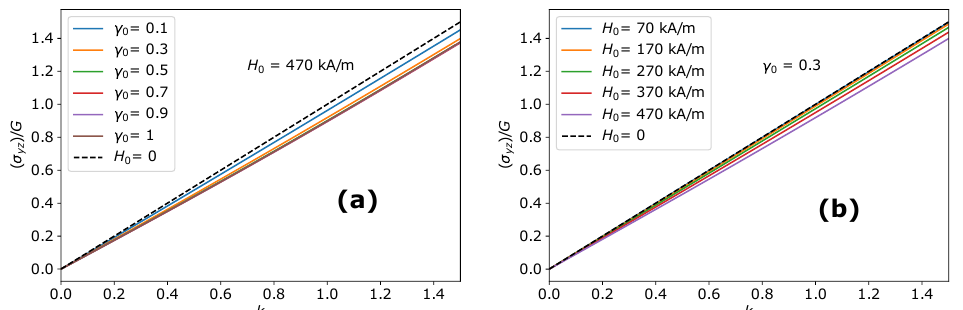
Figure 6. The stress-strain behavior of MAEs in the y - z plane: ( a ) Shear stress σ yz as a function of the amount of shear k during the shear deformation in the y - z plane along y -direction for oblate MAEs at different values of the initial aspect ratio γ 0 . ( b ) Shear stress σ yz as a function of the amount of shear k during the shear deformation in the y - z plane along y -direction for an oblate MAE ( γ 0 = 0.3) at different values of the magnitude of applied magnetic field (cid:126) H 0